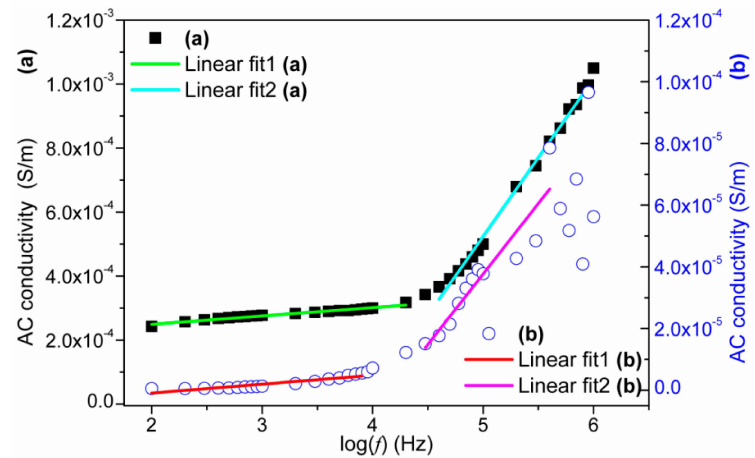
Figure 15. Frequency dependence AC conductivity ( σ ac ) of ( a ) sintered pellet at 1050 ˝ C (pink (S1050)) and ( b ) composite film (brown (S1050/PDMS)). Both materials show two different slopes below and above 5 ˆ 10 4 Hz, indicating a transition in electrical